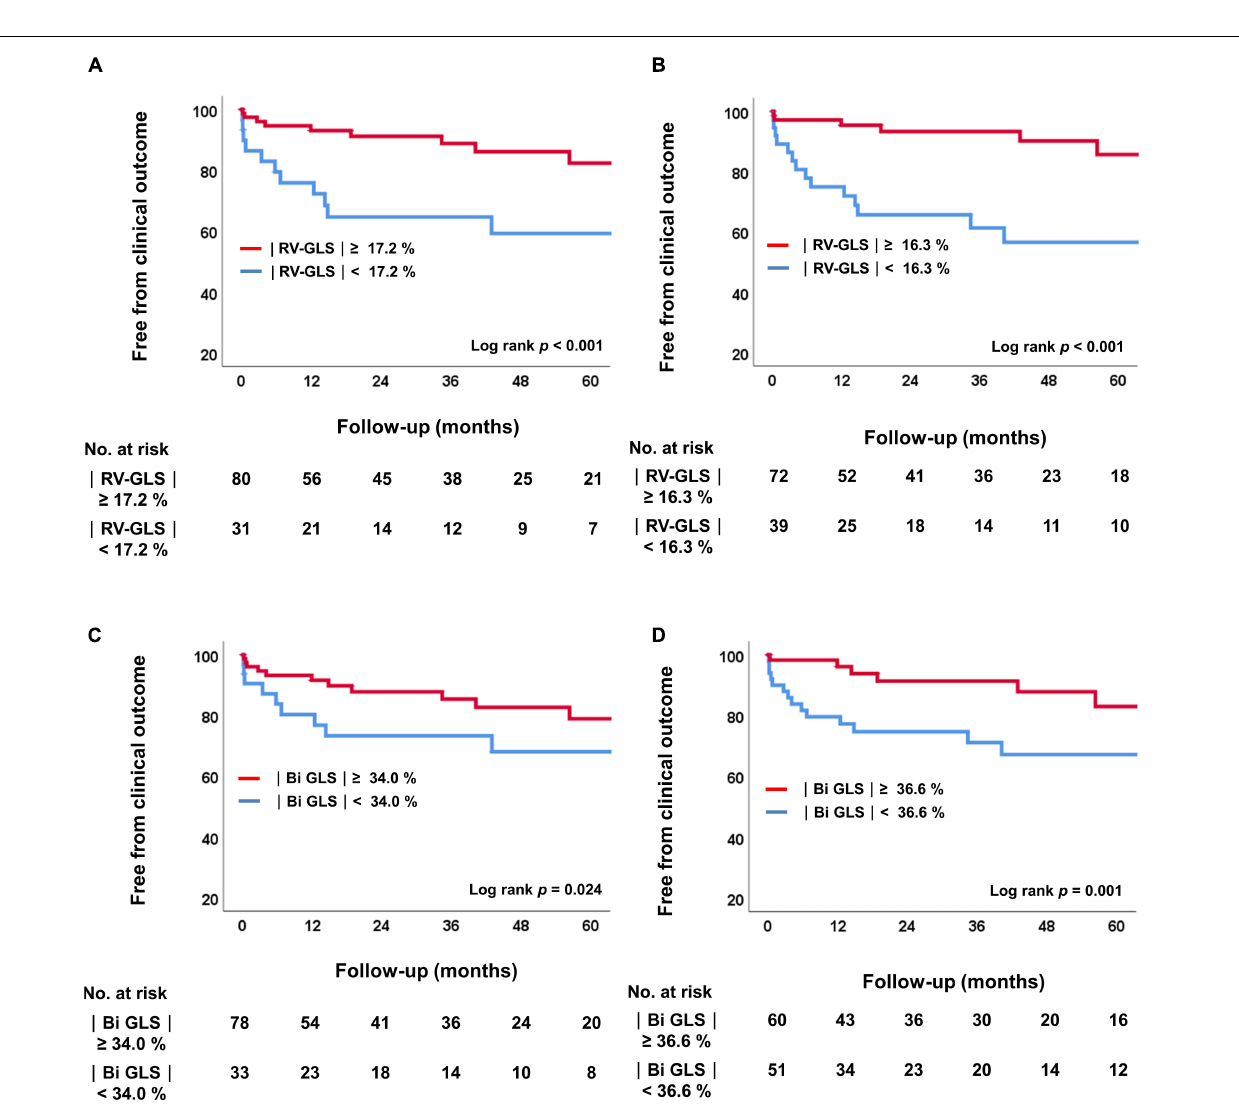
FIGURE 4 | Kaplan-Meier analysis of freedom from clinical outcomes. (A) Comparison of two groups according to the cutoff value for |RV-GLS| preop . (B) Comparison of four groups according to the cutoff value for |RV-GLS| postop . (C) Comparison of two groups according to the cutoff value for biventricular |GLS| preop . (D) Comparison of four groups according to the cutoff value for biventricular |GLS| postop . RV, right ventricle; |GLS|, absolute value of global longitudinal